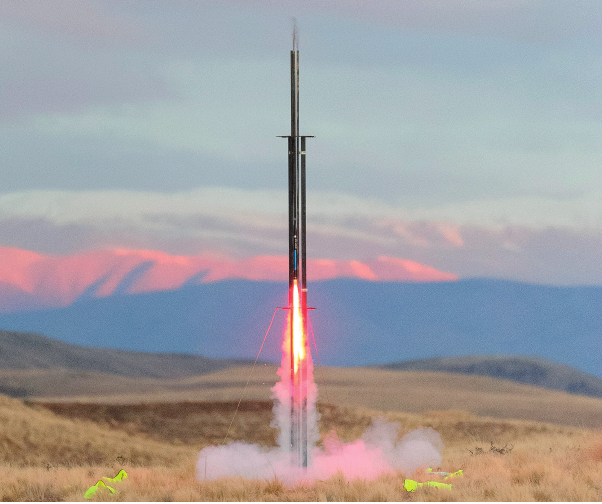
Figure 13. Milly rocket leaving the launch guide.